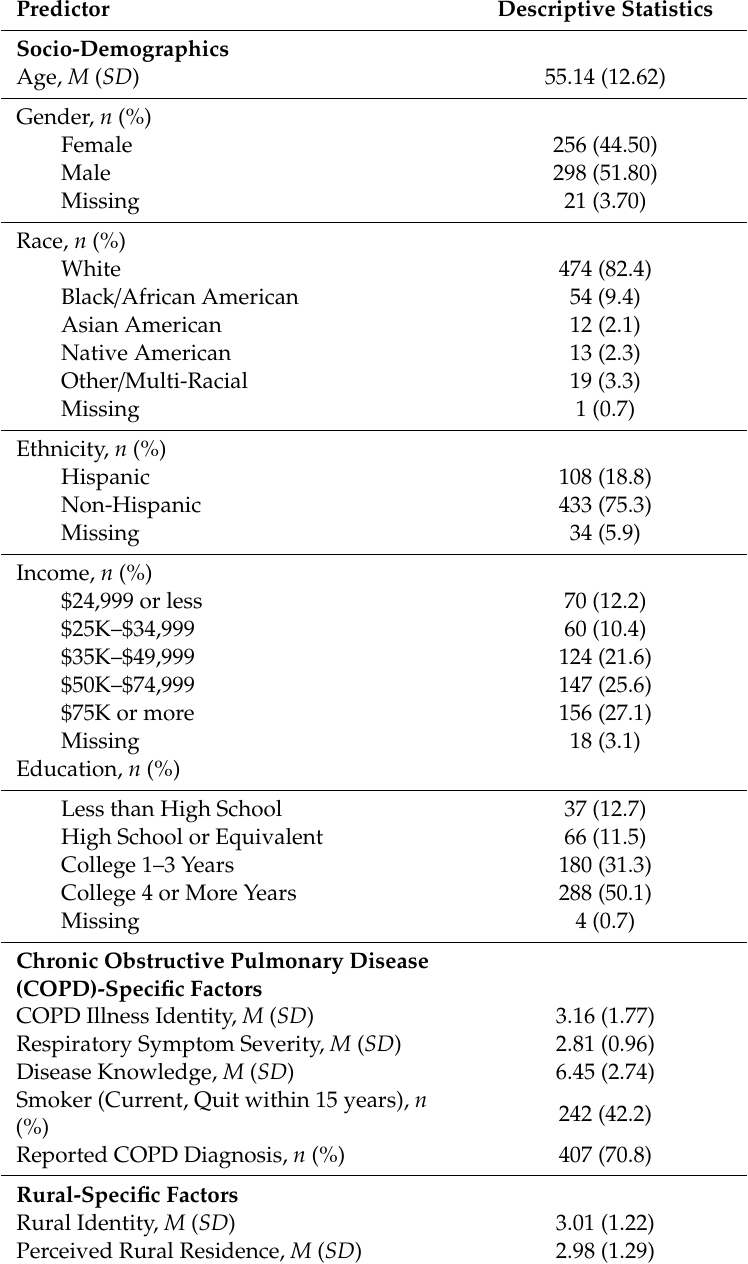
Table 1. Characteristics of the sample ( n =